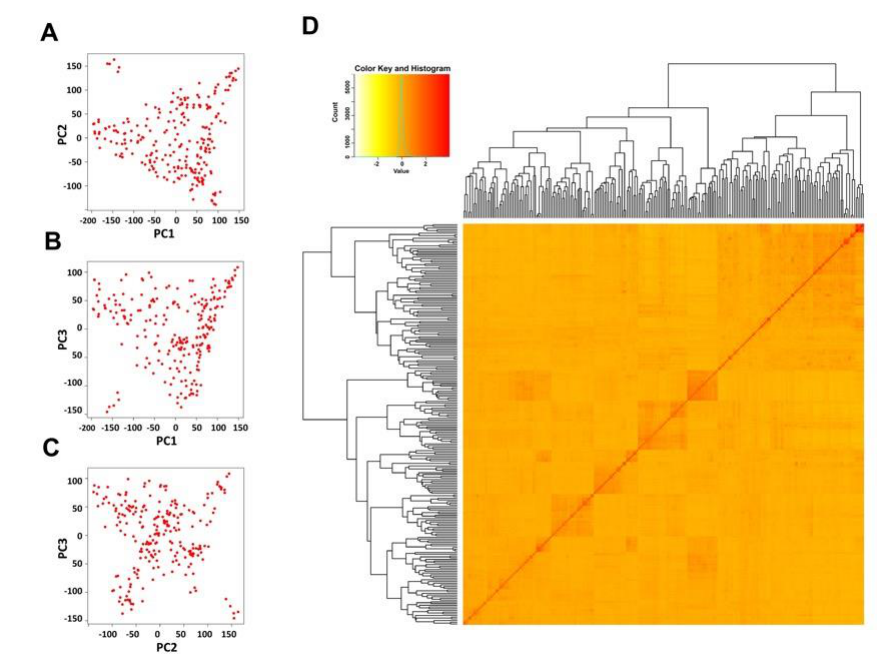
Figure 2. Principal component analysis (PCA) and kinship relatedness analysis of 236 genotypes. ( A – C ) Variation of the first three principal components (PCs): ( A ) PC1 vs. PC2, ( B ) PC1 vs. PC3 ( B ), and PC2 vs. PC3 ( C ). ( D ) Kinship matrix of 236 individuals displayed as a heatmap.